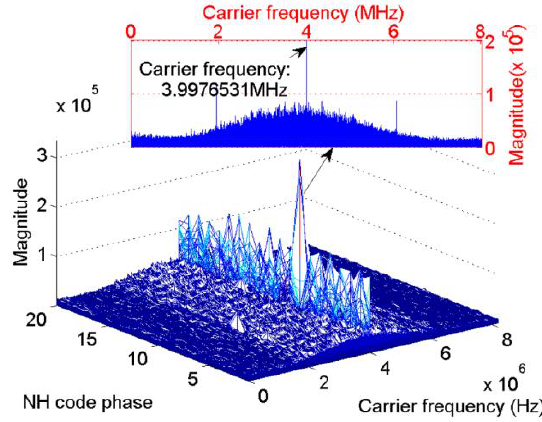
Figure 16. Real data test results of the proposed algorithm.